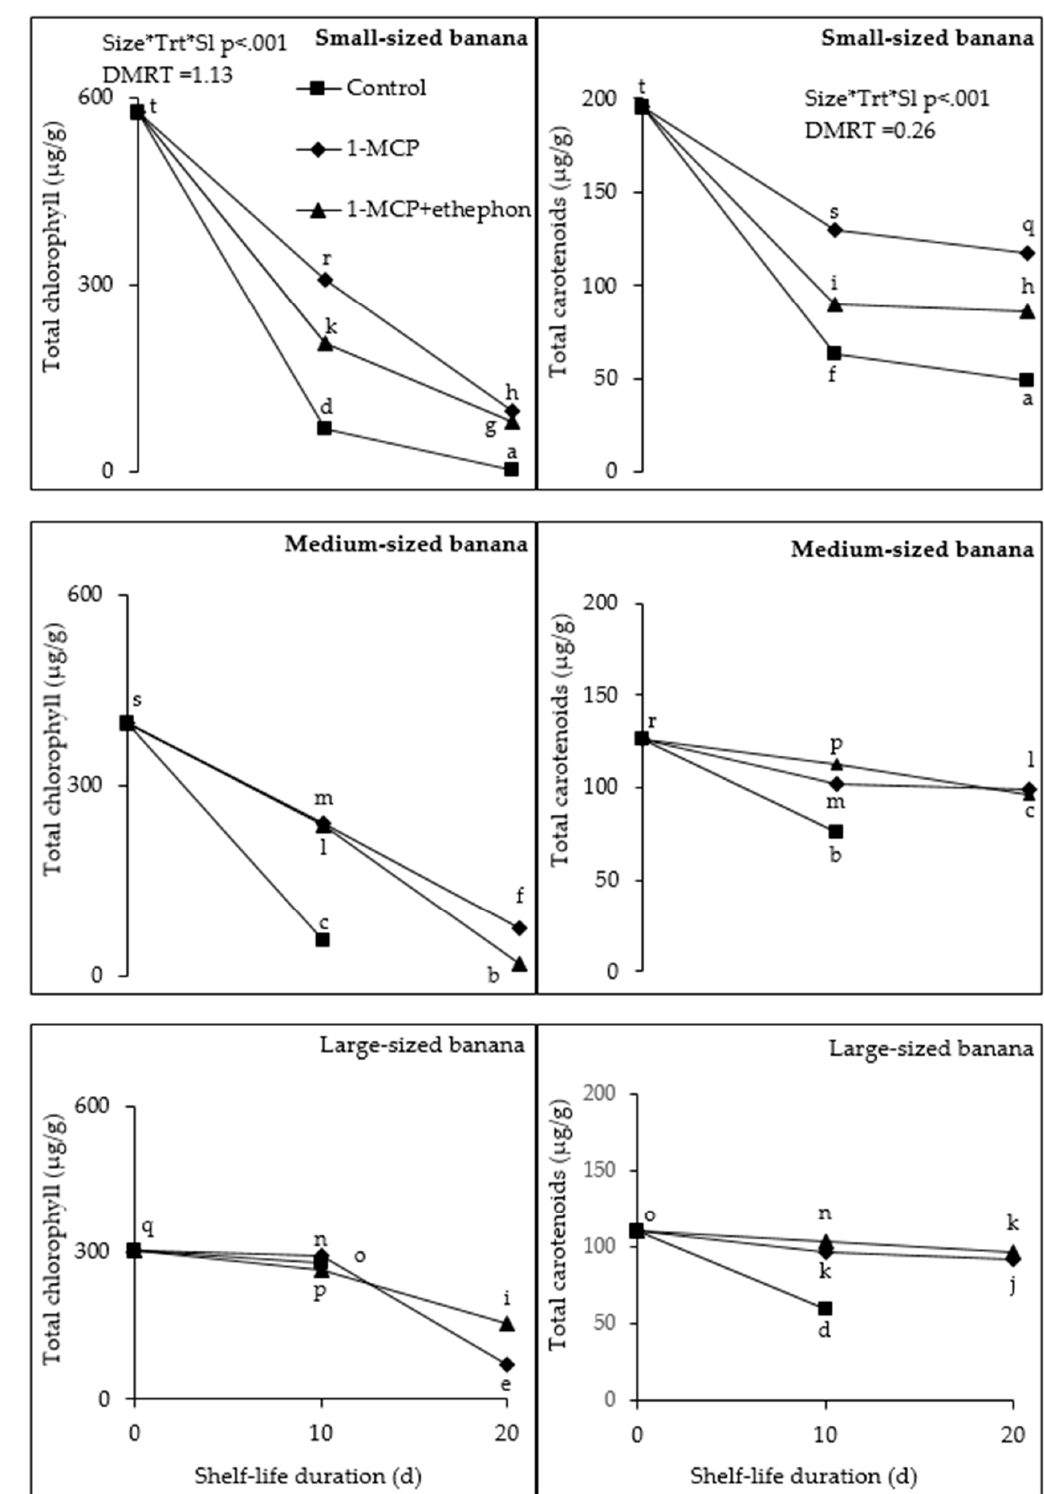
Figure 2. Effect of fruit size, 1-MCP, and shelf-life and their interaction on total chlorophyll (left column) and carotenoids (right column) at ambient temperature. Size*Trt*Sl represents significant interaction of fruit size, 1-MCP, and shelf-life duration at p < 0.05 according to Duncan Multiple Range Test (DMRT). Each value is a mean of four replicates ( n = 4) ± standard error. Control fruit were removed at 15 d after they were fully yellow, indicating that they were fully ripe.